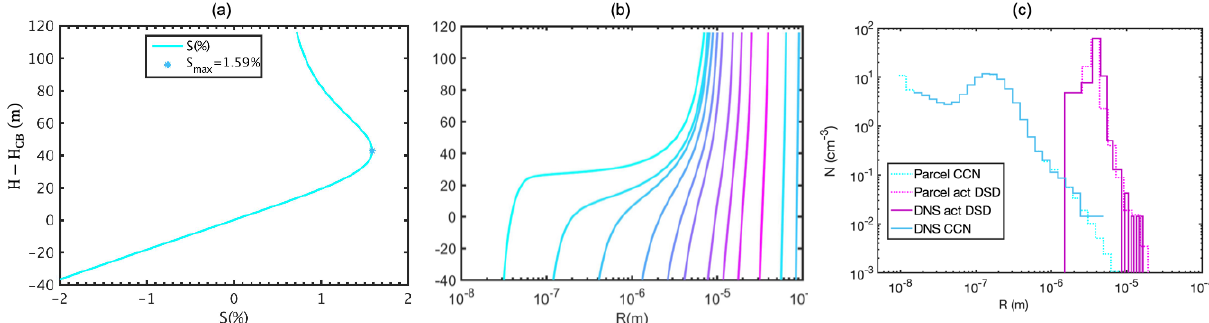
Figure 2. (a) Supersaturation and (b) radius of droplets with different initial wet sizes varying with the height from cloud base ( H − H CB ). Only bins of activated particles are illustrated in (b) . (c) The background natural CCN (dry particle) size distribution in the parcel model (light dotted blue histogram) and in the DNS model (darker solid blue histogram), as well as the droplet size distribution at maximum supersaturation ( S max = 1 . 59%) in the parcel model (light dotted violet histogram) and in the DNS model (darker solid violet histogram). The vertical axis denotes the number concentration of the assigned particle size in the